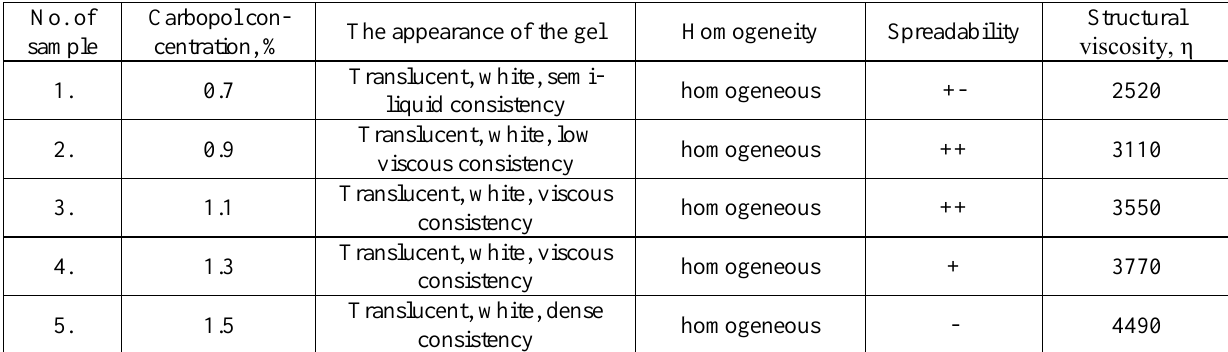
Physico-chemical characteristics of gel compositions based on Carbopol ® Ultrez